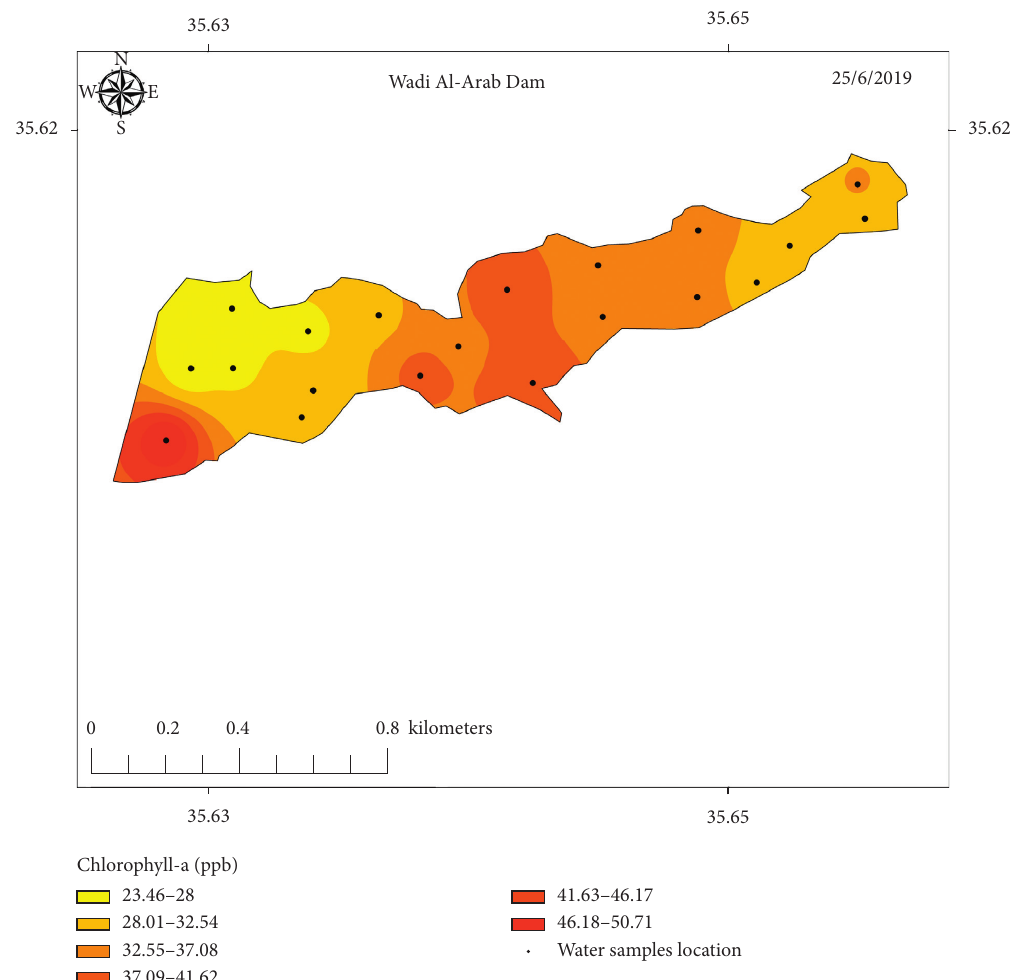
Figure 7: Concentration distribution of Chl-a through Wadi Al-Arab Dam’s